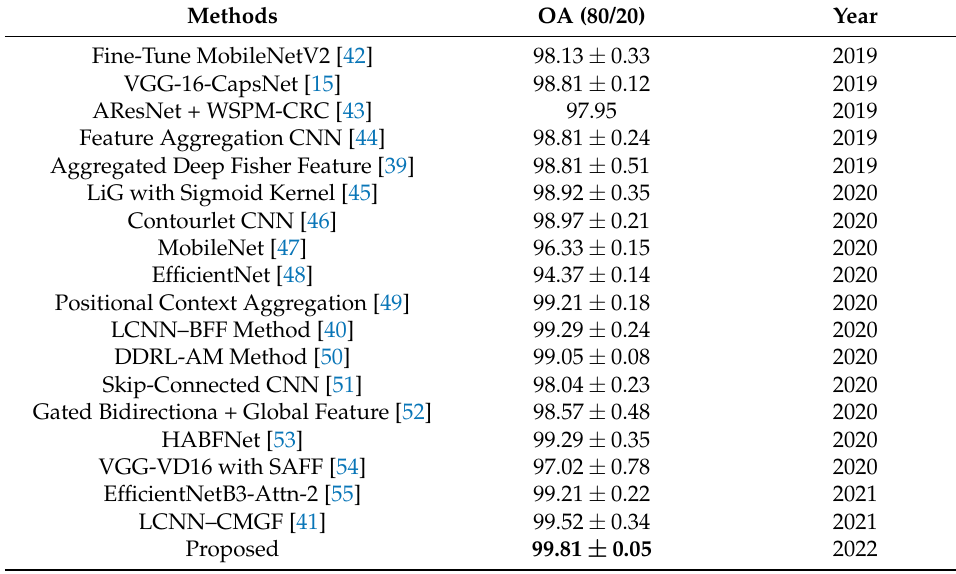
Table 6. OA comparison on UCM